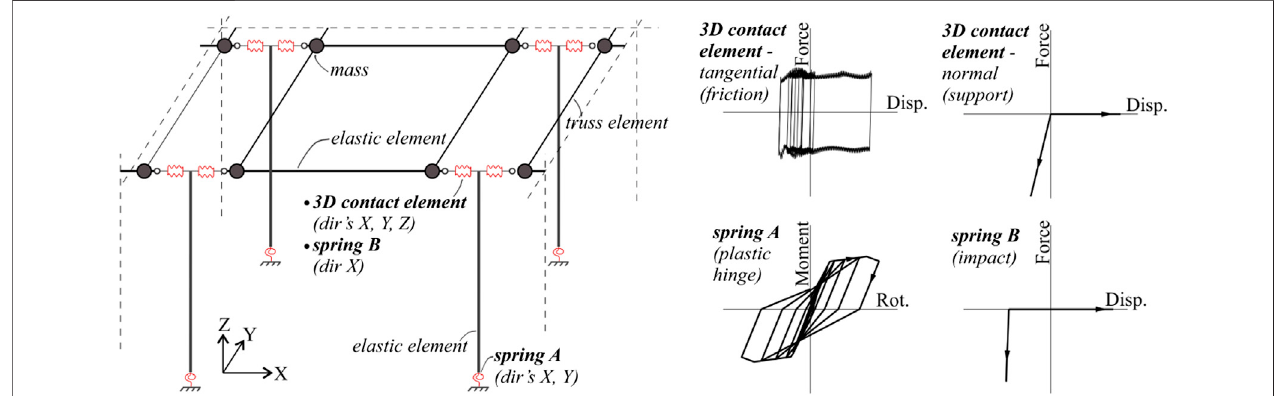
Frontiers in Built Environment |